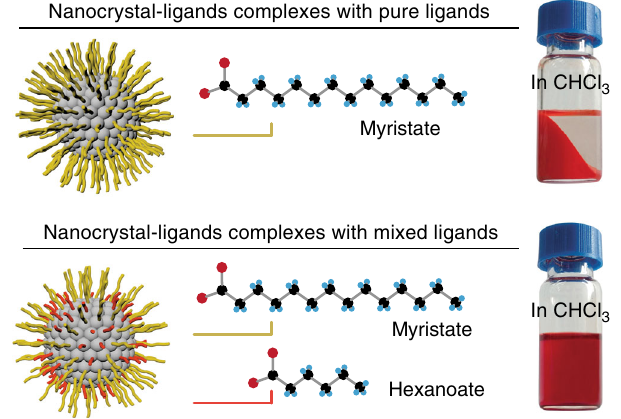
Fig. 1 Solubility enhancement by mixing long and short ligands. The graphs illustrate nanocrystal-ligands complexes with pure ligands of myristate, or with mixed ligands of myristate and hexanoate. On the right: optical pictures showing the macroscopic differences between nanocrystal-ligands complexes with pure ligands and nanocrystal-ligands complexes with mixed ligands in chloroform solvent. The vials contain equal weight (0.25 g) of puri fi ed samples in 0.8 mL of chloroform. The nanocrystal-ligands complexes with mixed ligands dispersed completely while the nanocrystal- ligands complexes with pure ligands precipitate. The size of nanocrystal core is 3.0 ± 0.2 nm as determined by